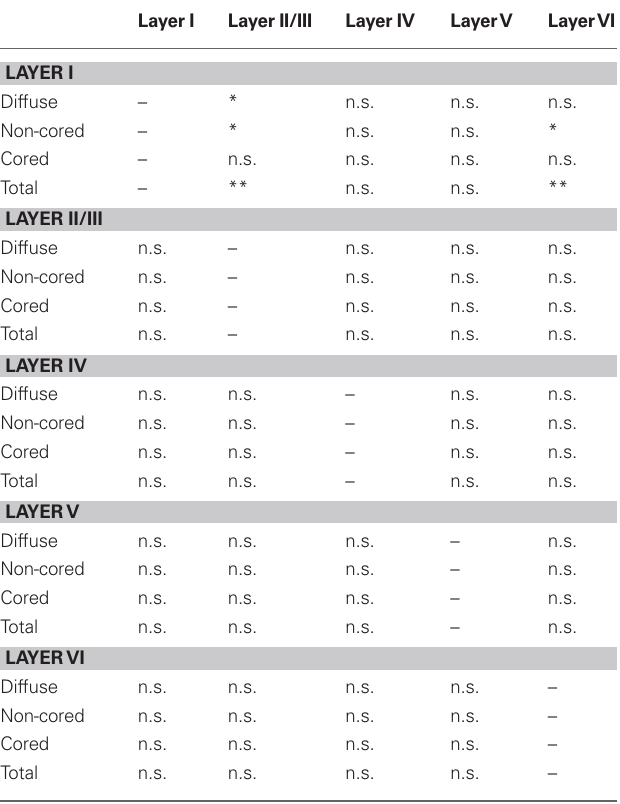
Table 4 | Statistical comparisons and degree of signifi cance ( p < *0.05, **0.01, ***0.001) in the percentage of contact with neurons of different type of plaques among cortical layers I–VI in APP/PS1 transgenic